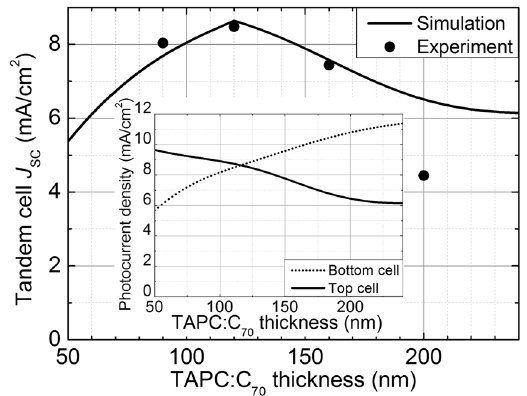
Figure 5. Calculated and measured short-circuit current densities ( J SC ) of the transfer-fabricated tandem devices with different TAPC:C 70 thicknesses ( t ). The calculated (line) and measured (circle) values of J SC for the transfer-fabricated tandem device shown in Fig. 1 as functions of t . The inset shows the photocurrent densities of the top (solid line) and bottom (dotted line) subcells as functions of t